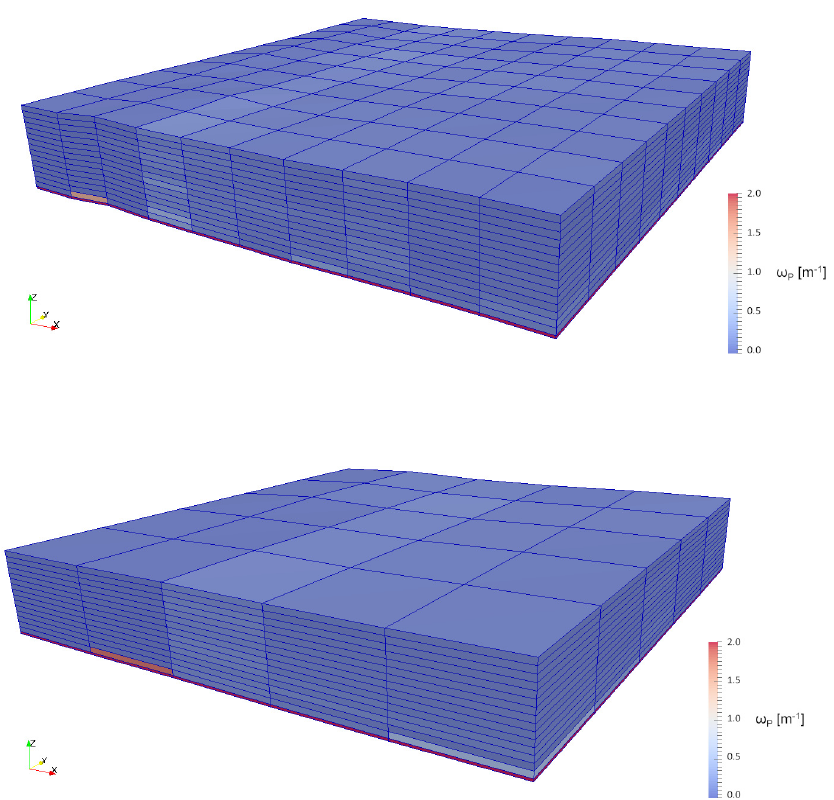
Figure 14. Vegetation parameter for a young forest close to the river Kinzig derived from ALS data with three different resolutions. Grids are 1, 2, 5 and 10 m. The vertical grid is terrain fitted, and the complete block is 8 m high, which is less than the tree height.